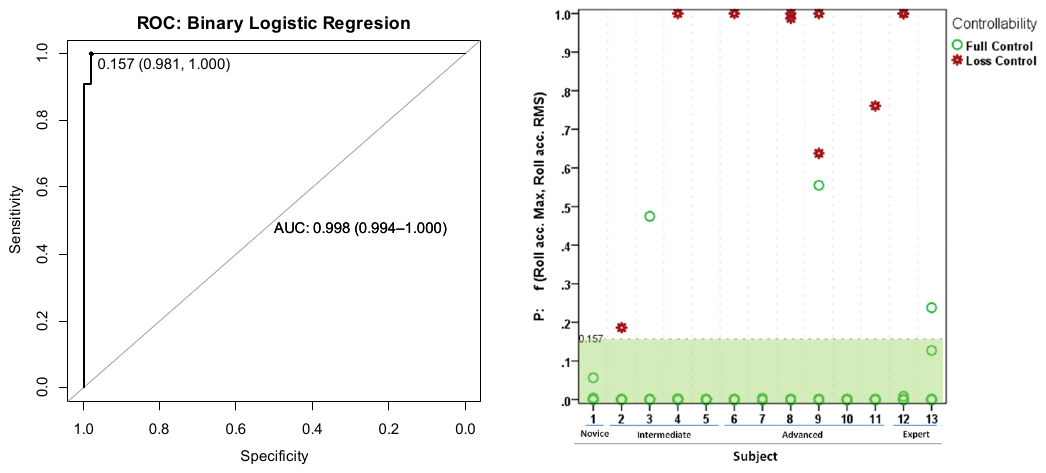
Appl. Sci. 2020 , 10 , x FOR PEER REVIEW Figure 8. Model-2: ROC and scatter plot of loss of control probability by subject for the 165 braking trials.